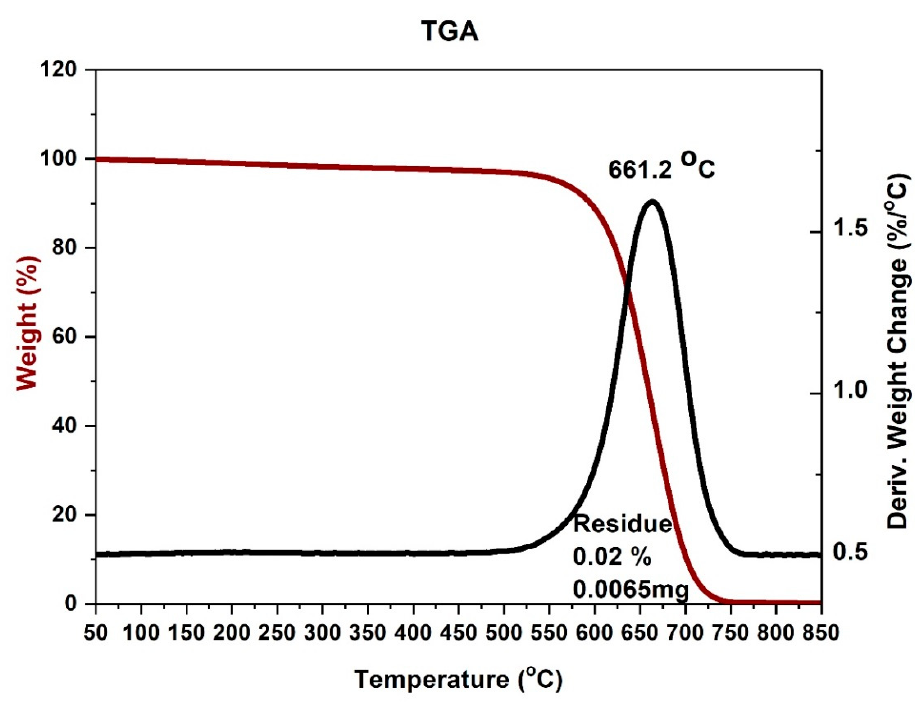
Figure 7. TGA of ferromagnetic MWCNTs—sample no. 2 (high flow velocity).